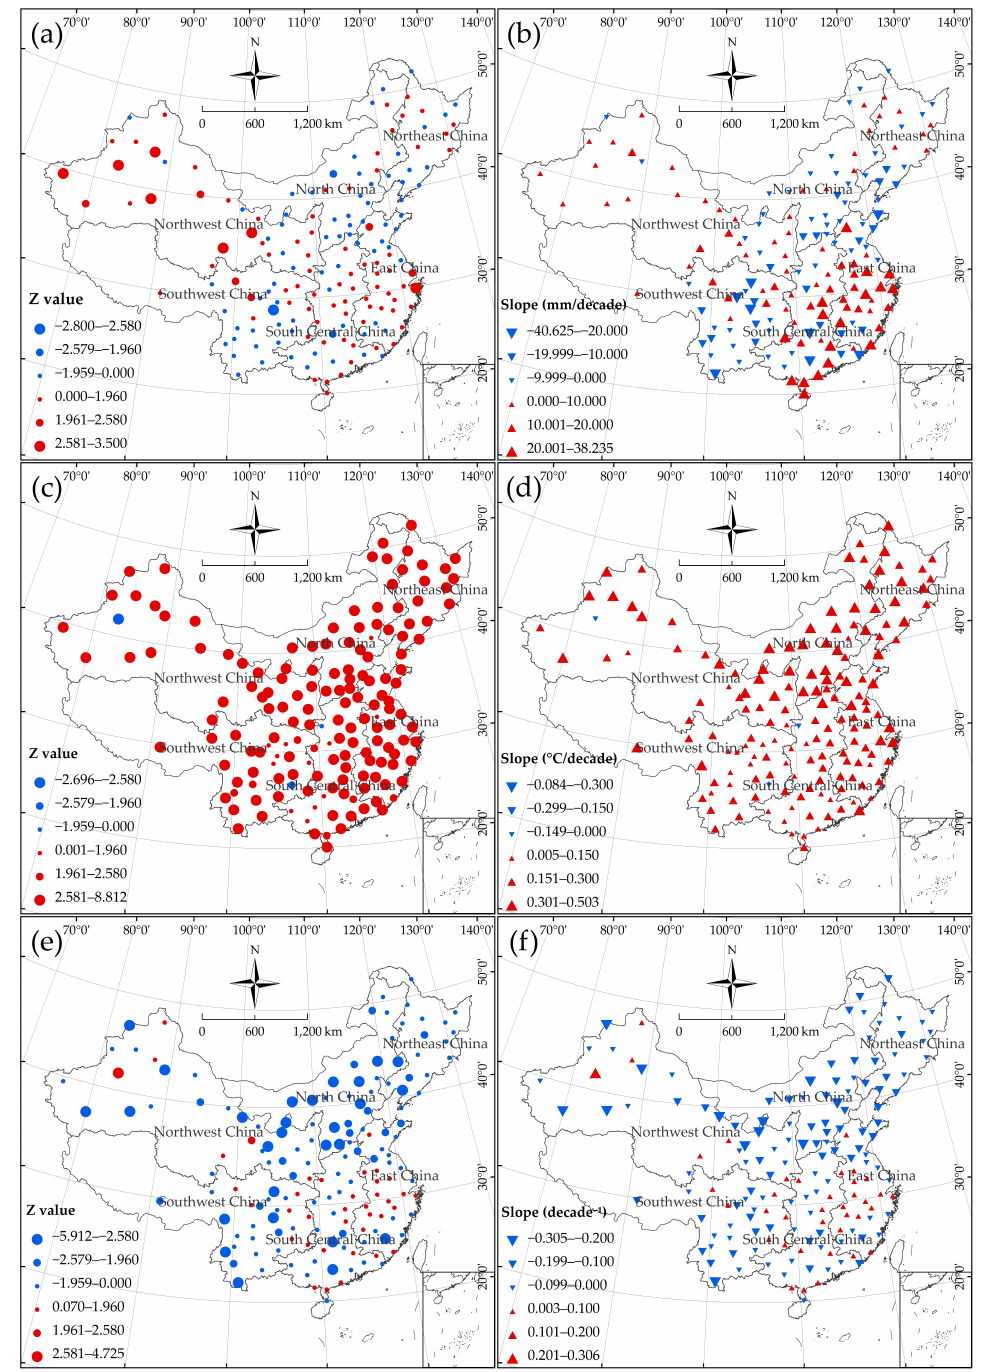
Figure 6. Spatial distribution of the Z-statistic for the temporal trend based on the MMK test during 1951–2021: ( a ) precipitation; ( c ) temperature; and ( e ) the SPEI. A Z-statistic greater than 1.96 indicates a significant trend at the 95% confidence level, and greater than 2.58 indicates a significant trend at the 99% confidence level. Spatial distribution of the trend magnitude based on the Sen slope during 1951–2021: ( b ) precipitation; ( d ) temperature; and ( f ) the SPEI. Red (blue) indicates an upward (downward)